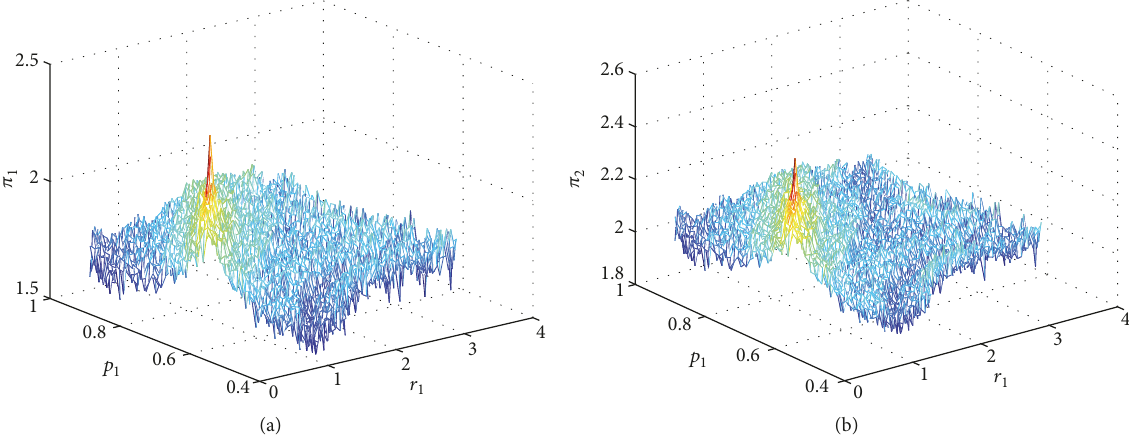
Figure 18: The average profits with respect to initial 𝑟 1 and 𝑝 1 when 𝜃 = 0.5 , 𝛼 = 0.5 , 𝑤 1 = 𝑤 2 = 0.5 , 𝛼 1 = 0.32 , and 𝛼 2 = 0.25 .